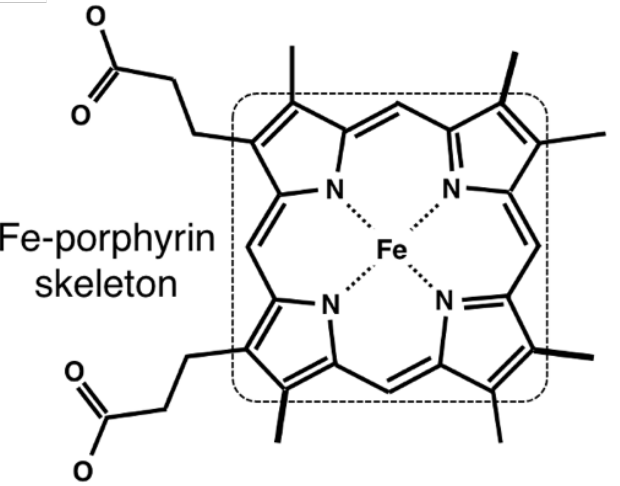
Figure 1. Chemical structure of heme. Fe–porphyrin skeleton is enclosed by a square-dotted line.